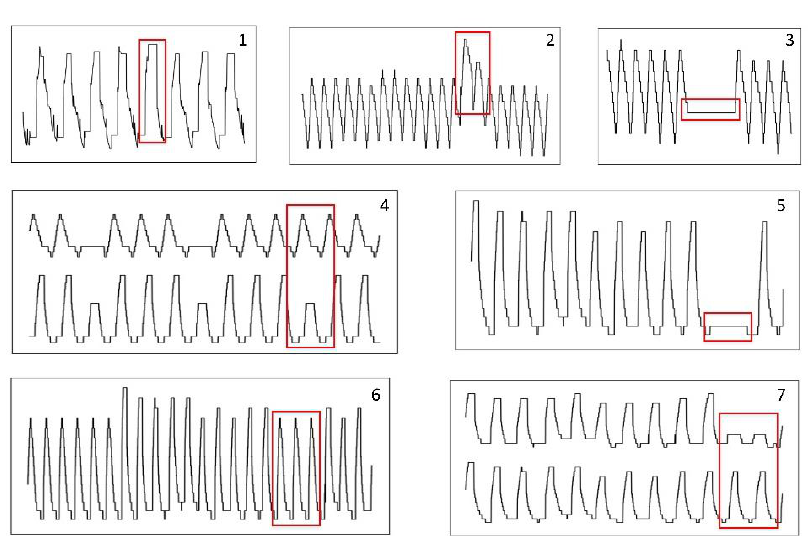
Figure 1. Examples of anomalies (highlighted in red boxes) considered in this